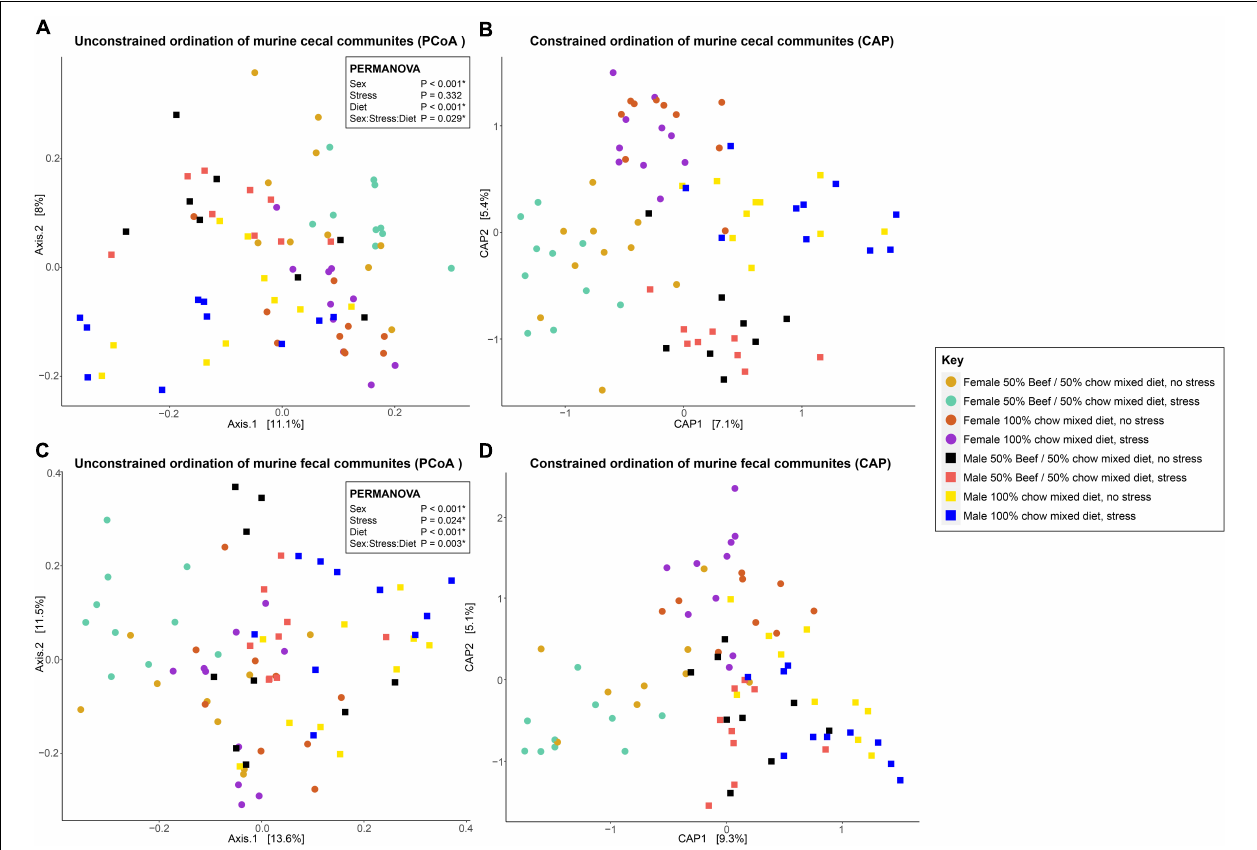
FIGURE 2 | Unconstrained (principal coordinates analysis, PCoA) ordinations of cecal (A) and fecal (C) bacterial communities, and constrained (canonical analysis of principal coordinates, CAP) ordinations comparing murine cecal (B) and fecal (D) bacterial communities visualized by the fixed effects of diet, sex and stress. Stress encompassed a chronic alternating forced swim and restraint stress paradigm as described in section “Materials and Methods.” Distances between samples denote Bray-Curtis dissimilarity measures. CAP analysis was constrained by Eq.